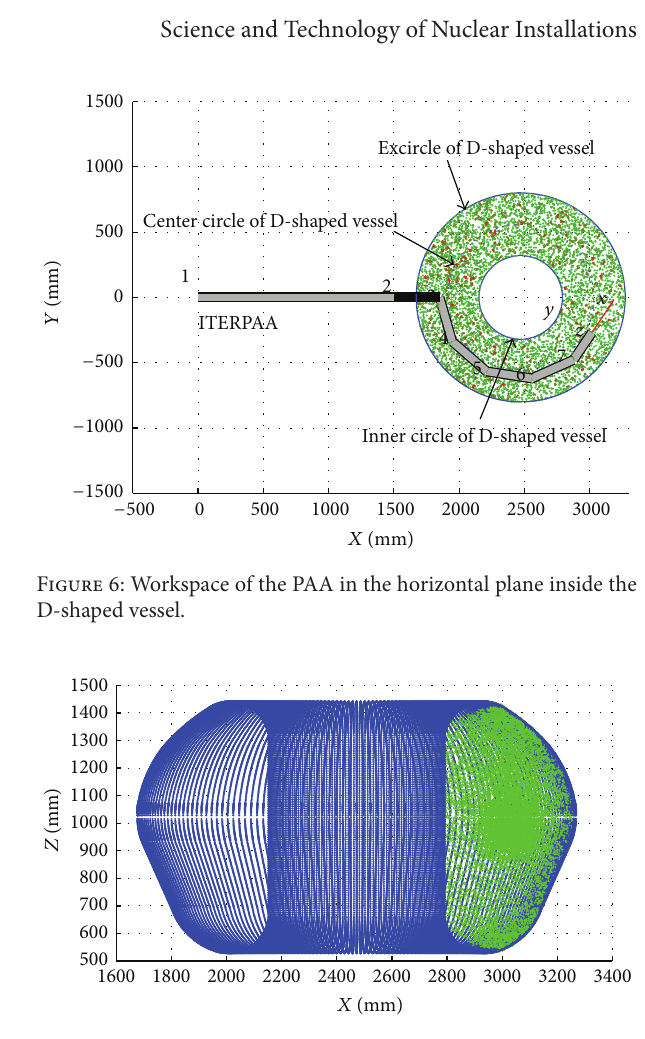
Figure 7: Workspace simulation of the ATM in the D-shaped